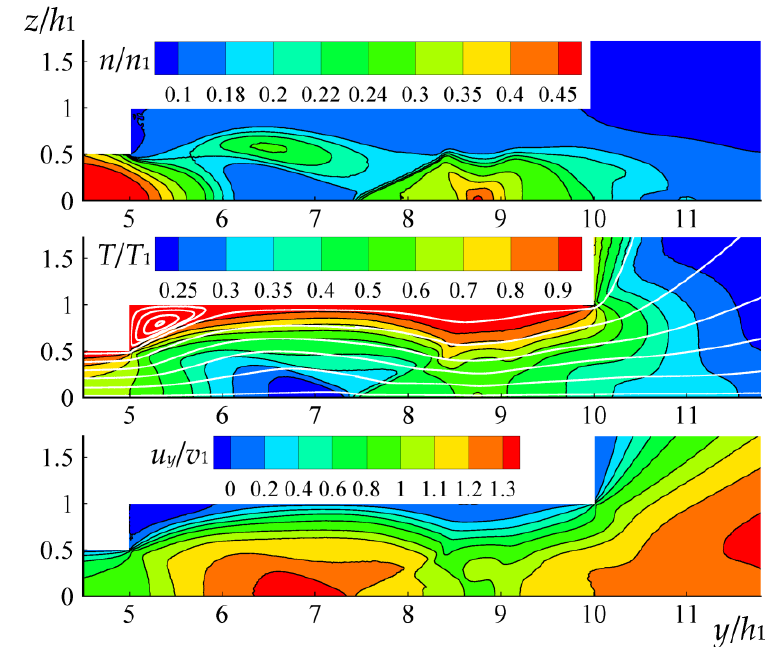
Figure 3. Dimensionless density n / n 1 , temperature T / T 1 , and longitudinal bulk velocity u y / v 1 in the yz-plane inside and downstream a channel ( l / h 1 = 10) with sudden expansion ( ℎ 2 ℎ 1 ⁄ = 2) at rarefaction δ = 10 3 (the temperature image also displays gas streamlines) [39].